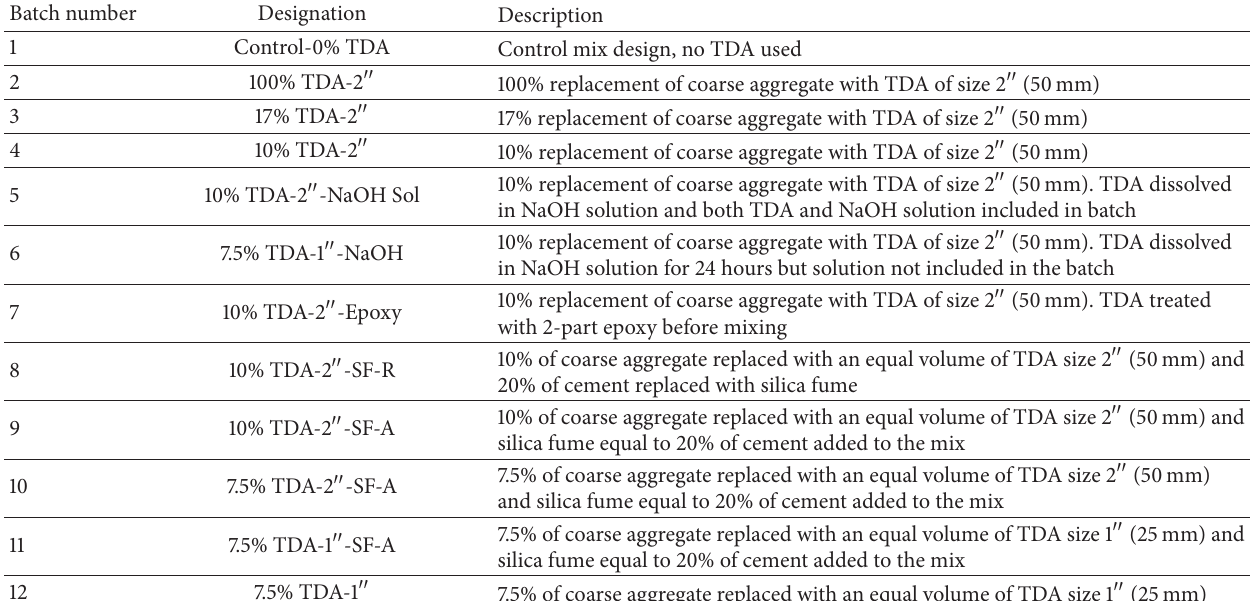
Figure 3: Summary of compressive test results with loading up to concrete failure at 7 days and 28 days. The batch designation is as shown in Table 2. Table 2: Batch number, designation, and